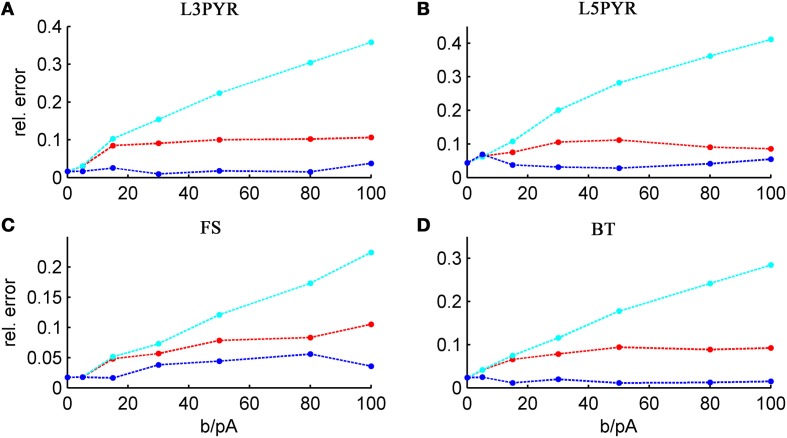
Average relative prediction error as a function of spike-triggered adaptation for different neuron types. For the 4 averaged neuron type parameters (A: layer-3 pyramidal cell, B: layer-5 pyramidal neuron, C: fast-spiking and D: bitufted interneuron), the average prediction error (Equation 32) is shown as a function of adaptation parameter b for the three theoretical approximations (ν0: cyan, ν0 + ϵ2 ν2: blue, 〈 νEIF 〉w: red). Relative prediction error was averaged across σIsyn ∈ {100, 200, 300, 400, 500, 600} pA and μIsyn = cell-specific rheobase.